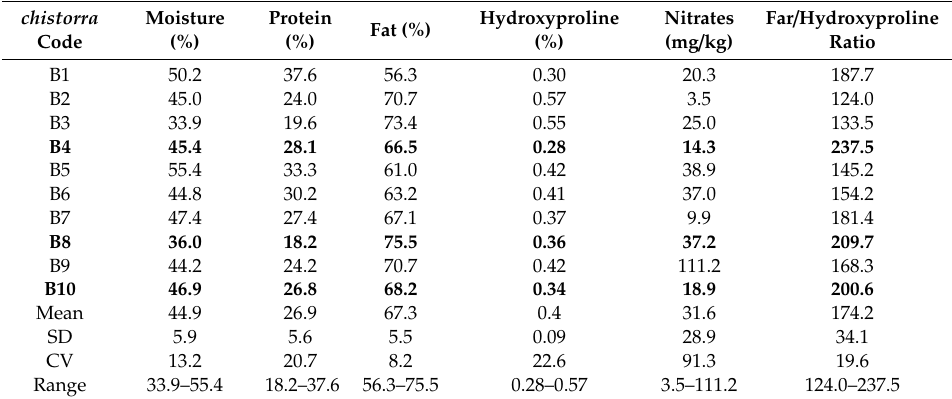
Table 2. Raw composition of chistorra